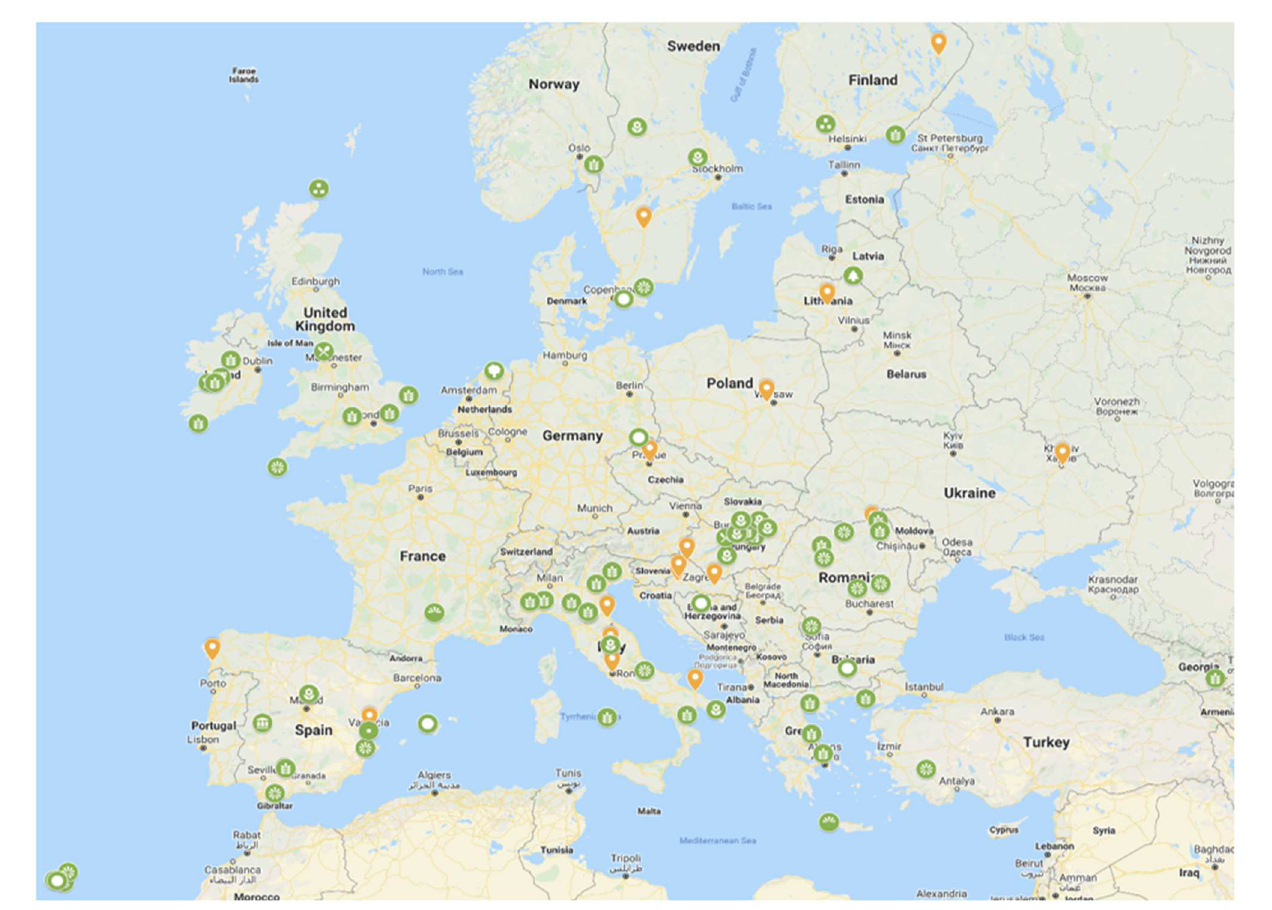
FIGURE7 Stakeholders expressing their wish to join the European network for in situ conservation and sustainable use of plant genetic resources a . a https://more.